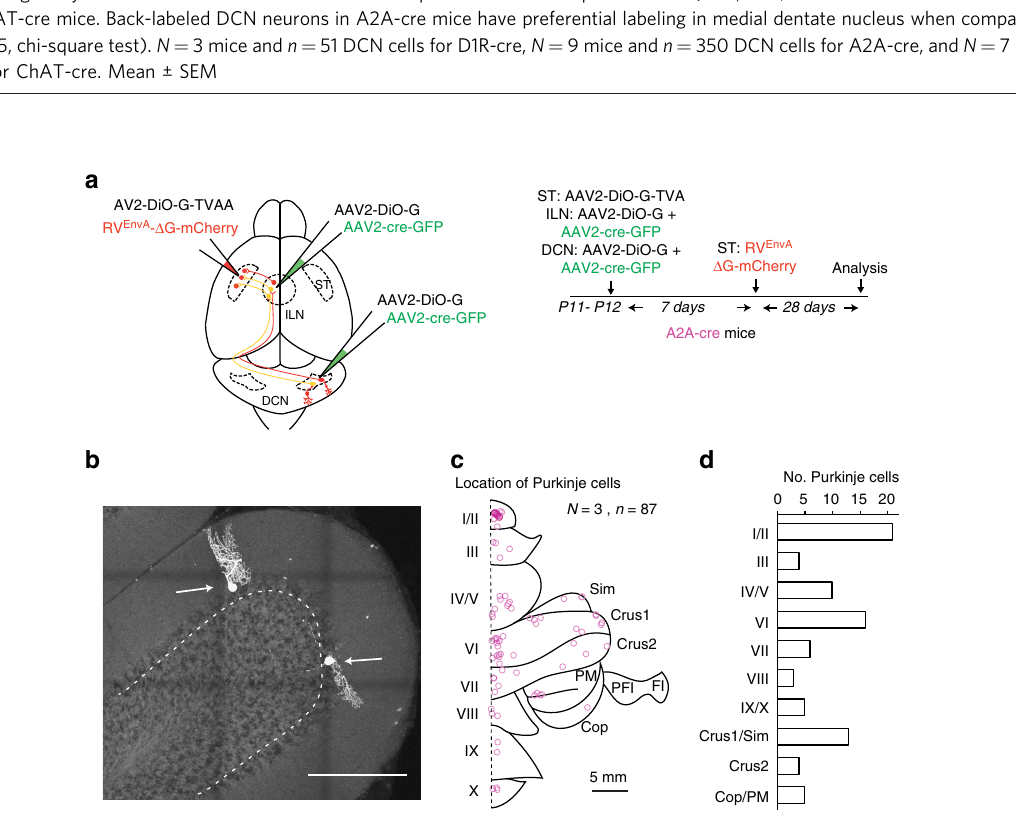
Fig. 4 Dorsal striatal iMSNs receive information from all the cerebellar lobules. a Stereotaxic injection and analysis scheme. Injections in A2A-cre mice ( N = 3) are initiated at P11-P12. The procedure is as in Fig. 3, except performing an additional injection of AAV2-DiO-G/AAV2-cre-GFP at P11-P12 to express viral glycoprotein in the DCN. b Example of retrogradely labeled Purkinje cells in Crus 1 (arrows) marked by mCherry expressed from the transsynaptic rabies virus. Scale bar: 200 µ m. c Location of 87 retrogradely labeled Purkinje cells from tracings performed in three mice. Cell positions are mapped onto an unfolded map of the cerebellum. Scale bar: 5 mm. d Number of transsynaptically labeled Purkinje cells by cerebellar lobule. Note lobule 1/ 2, lobule 6 and Crus 1/Sim have the highest number of cells. Anatomical annotations: Cop copula of the pyramis; Crus 1 crus 1 of the ansiform lobule; Crus 2 crus 2 of the ansiform lobule; FI fl occulus; Sim simple lobule; PFI para fl occulus; PM paramedian